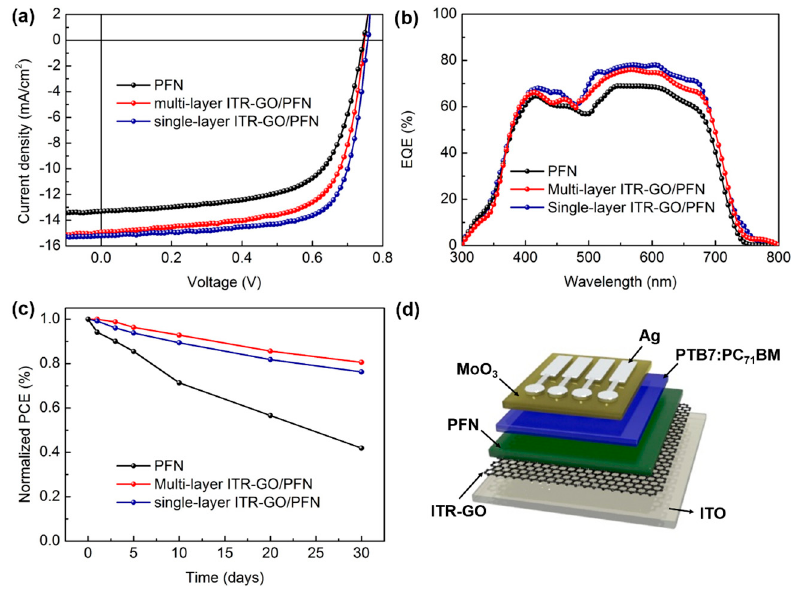
Figure 5. ( a ) Current density-voltage (J-V) curves of organic solar cells (OSCs) with different cathode interlayer (CILs). ( b ) External quantum efficiency (EQE) of OSCs with different CILs. ( c ) Stability of OSC devices in ambient air without encapsulation. ( d ) Device architecture of OSC.